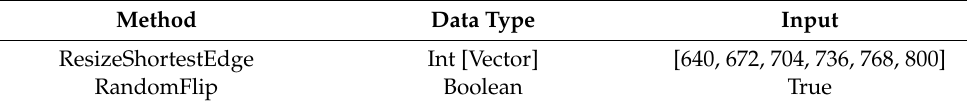
Table 2. Data augmentation method.